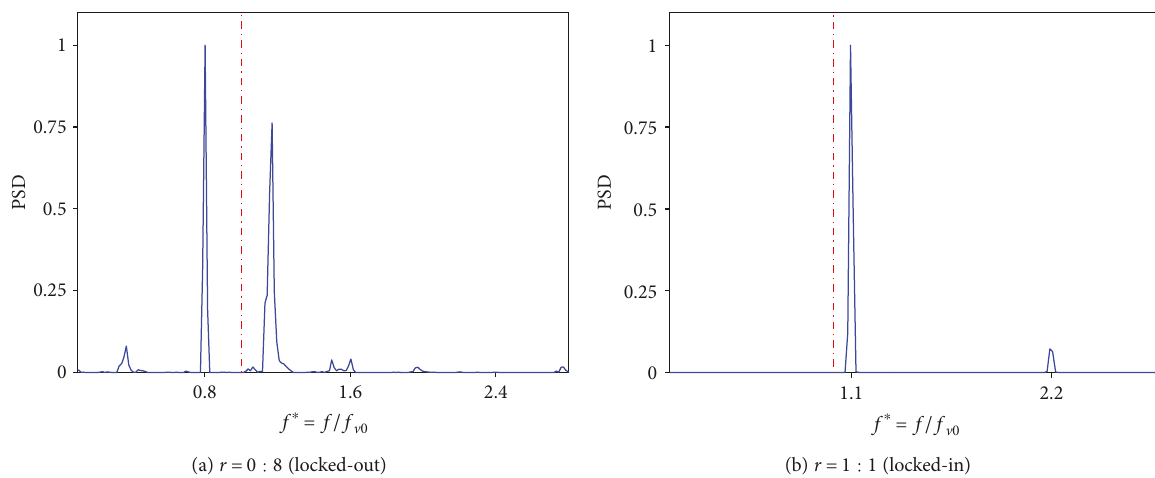
Figure 4: Spectra of the lift force coe ffi cient at α = 140 ° , for di ff erent frequency ratios showing the e ff ect of lock-out (a) and lock-in (b). PSD arbitrarily scaled. Dash-dot line indicates f ∗ = 1 , corresponding to the static case.